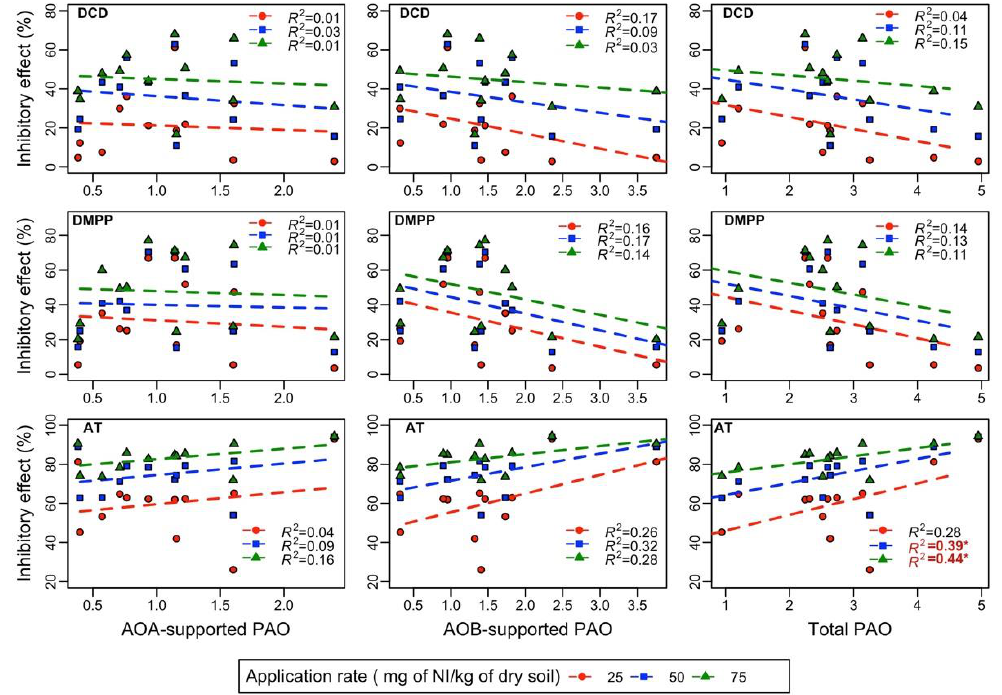
Figure 5. Relationship between the inhibitory effect (%) and ammonia-oxidizing archaea (AOA)-supported potential ammonia oxidization (PAO), ammonia-oxidizing bacteria (AOB)-supported PAO, and total PAO obtained using linear regression. * p < 0.05.